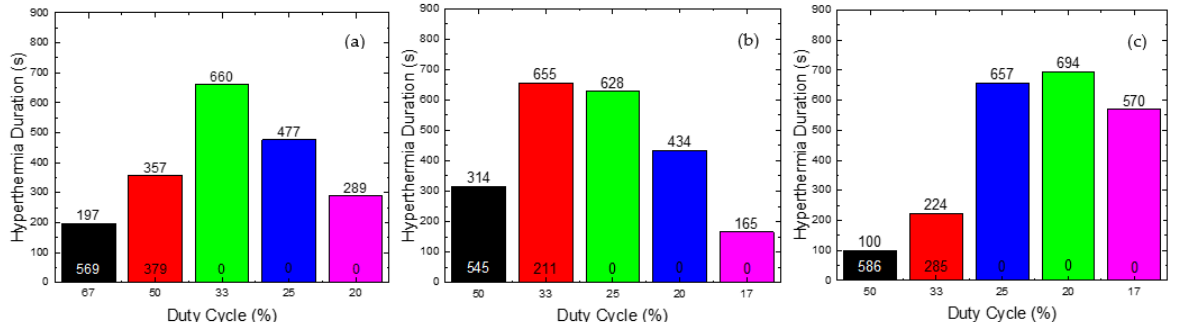
Figure 6. Hyperthermia Duration of CTP (written at the top of column) and HTP (at the bottom) as a function of Duty Cycle for ( a ) 45 mT, ( b ) 60 mT, and ( c ) 70 mT. The various Duty Cycles were evaluated with two criteria: (i) HTP sparing, i.e., its temperature should not exceed the value of 41 °C and (ii) the maximum Hyperthermia Duration for the CTP sample. After this evaluation, the final optimal values of Duty Cycle were found for each magnetic field used (45, 60 and 70 mT). The Duty Cycles equal to 20%, 25%, 33%, 50% and 67% are presented with purple, blue, green, red and black color respectively in (a) and (b). In (c) The Duty Cycles equal to 17%, 20%, 25%, 33% and 50% are presented with purple, green, blue, red and black color respectively.